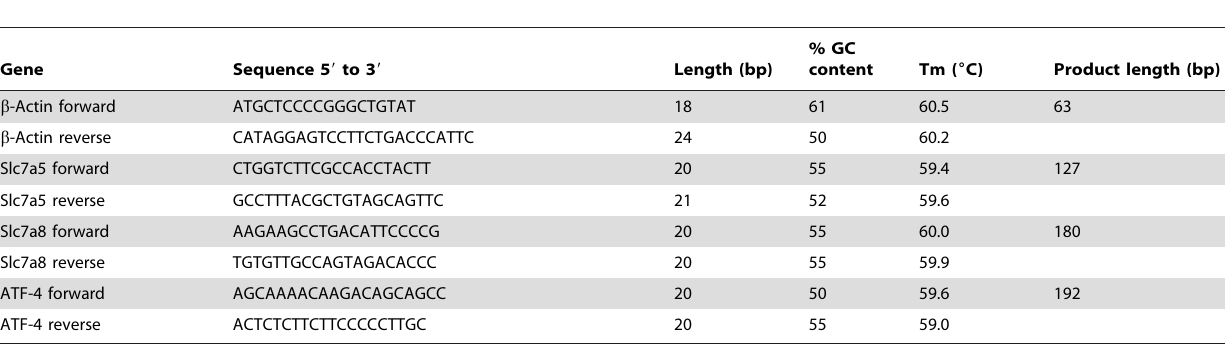
Table 2. Sequences of primers used to quantify mRNA by PCR (Q-PCR analysis) alongside the melting temperature (Tm) of each primer